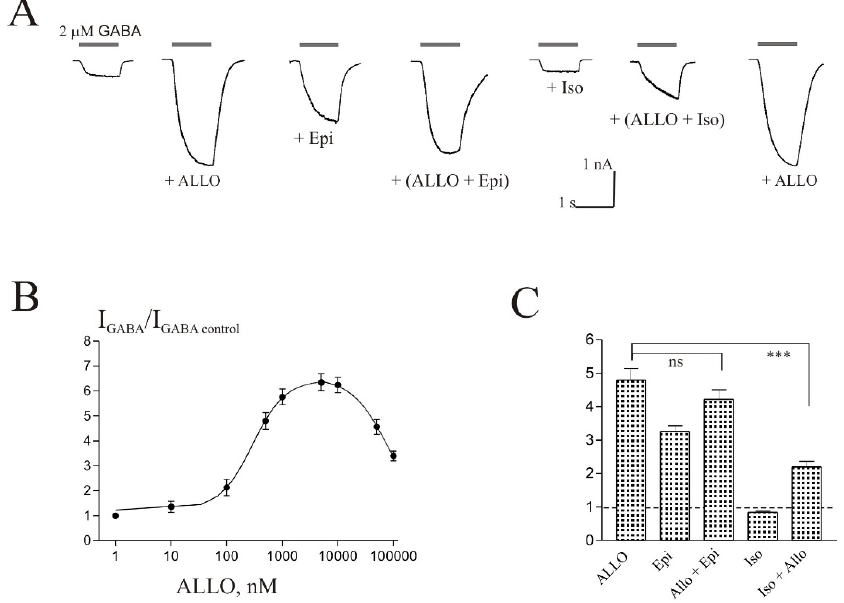
Figure 3. The effects of Epi and ALLO are not additive. ( A ) Representative traces of the current induced by 2 µ M GABA in control and during co-application with 0.5 µ M ALLO, 50 µ M Epi, ALLO + Epi, 100 µ M Iso, and ALLO + Iso. ( B ) Concentration dependence of ALLO effect on the normalized peak amplitude of I GABA . ( C ) Mean ± SEM of the normalized values of the peak amplitude of I GABA in the presence of ALLO (0.5 µ M), Epi (50 µ M), ALLO + Epi, Iso (100 µ M), Iso + ALLO. The control value is indicated by a dashed line. Data points represent average from seven cells. *** Means p < 0.001, ns means not significant.